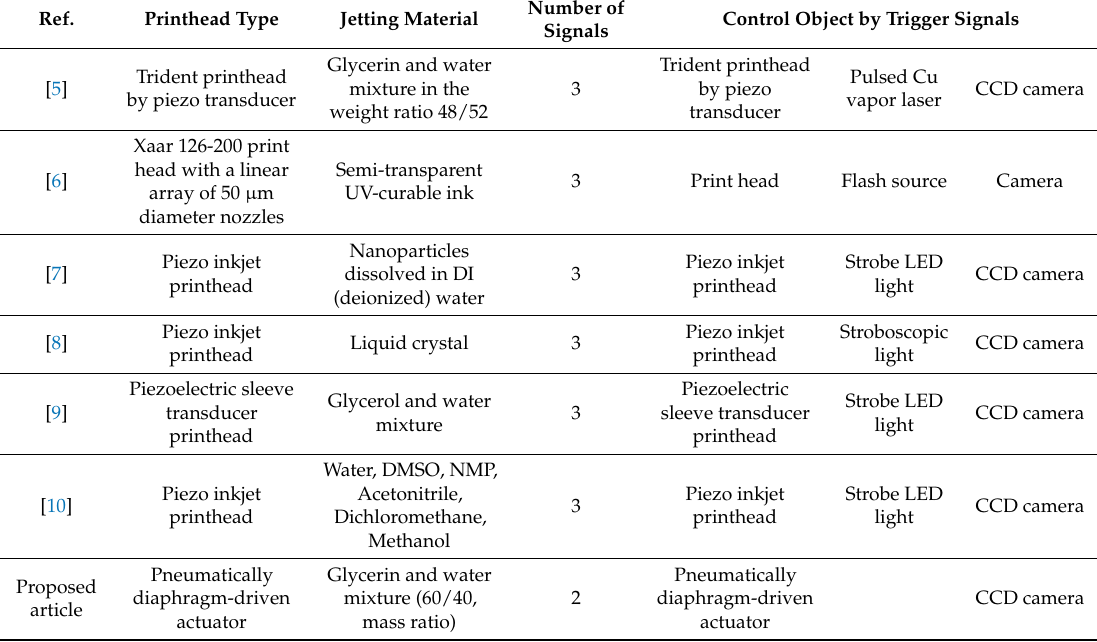
Table 1. Image acquisition system of microdroplets based on delay triggering and their features. Ref.